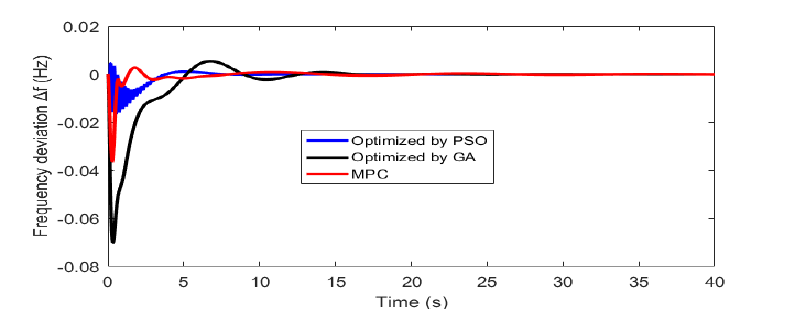
Figure 14. Frequency deviation in Area 2 for the third case.